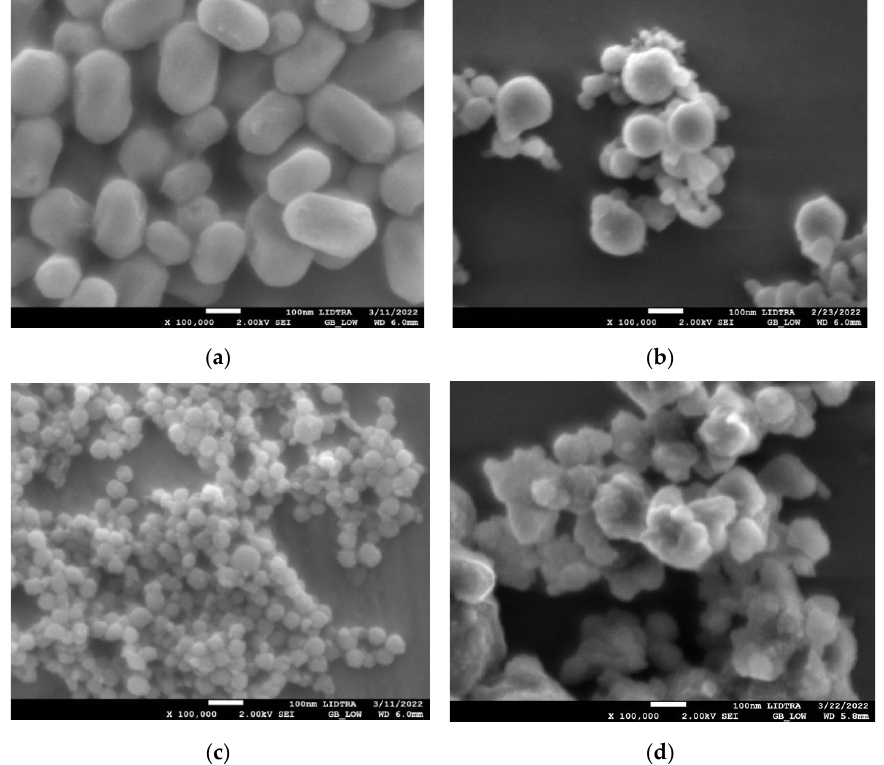
Figure 1. SEM micrographs of silica-gold nanoparticles with two different syntheses ( a ) blank S1, ( b ) blank S2, ( c ) Mullein S1, ( d ) Mullein S2.